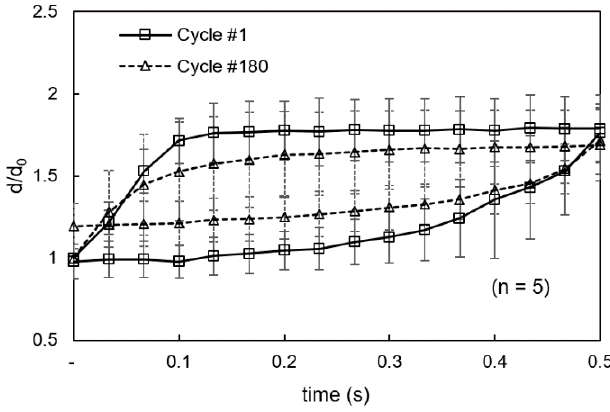
Figure 5. Creep and recovery test during cyclic loading conditions. Error bar represents the standard deviation.